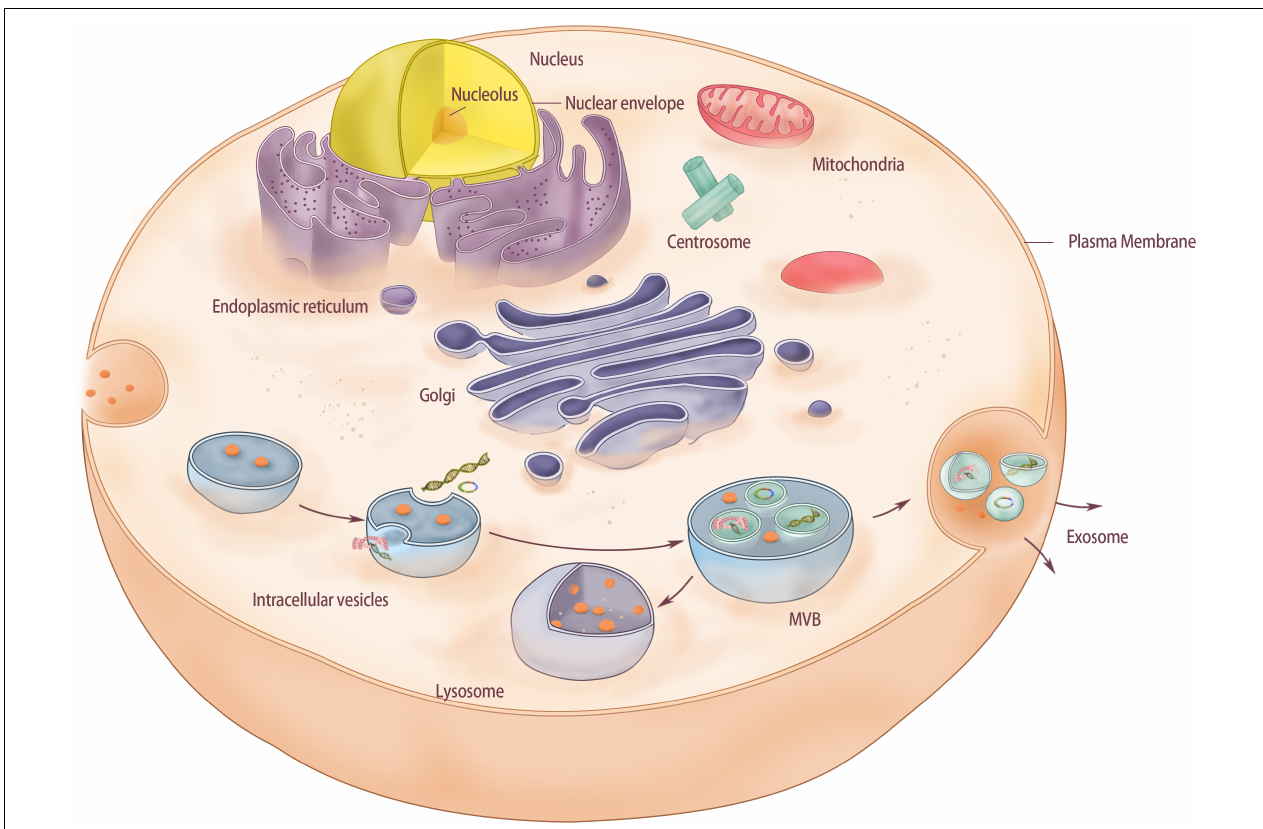
FIGURE 1 | The structure of exosomes derived from bone marrow mesenchymal stem cells. Membrane-driven endocytosis forms intracellular vesicles in the cytoplasm and stores substances from extracellular fluid in the vesicles. As intracellular vesicles mature gradually in the cytoplasm, intracellular vesicles continue to form inside the vesicles. Intracellular vesicles can store substances in the cytoplasm and form MVB. Finally, MVB fused with the cell membrane and released the intracavinal vesicles, which completed the release of exosomes. In this process, if MVB is directly fused with lysosomes in the cytoplasm, polycysts will be